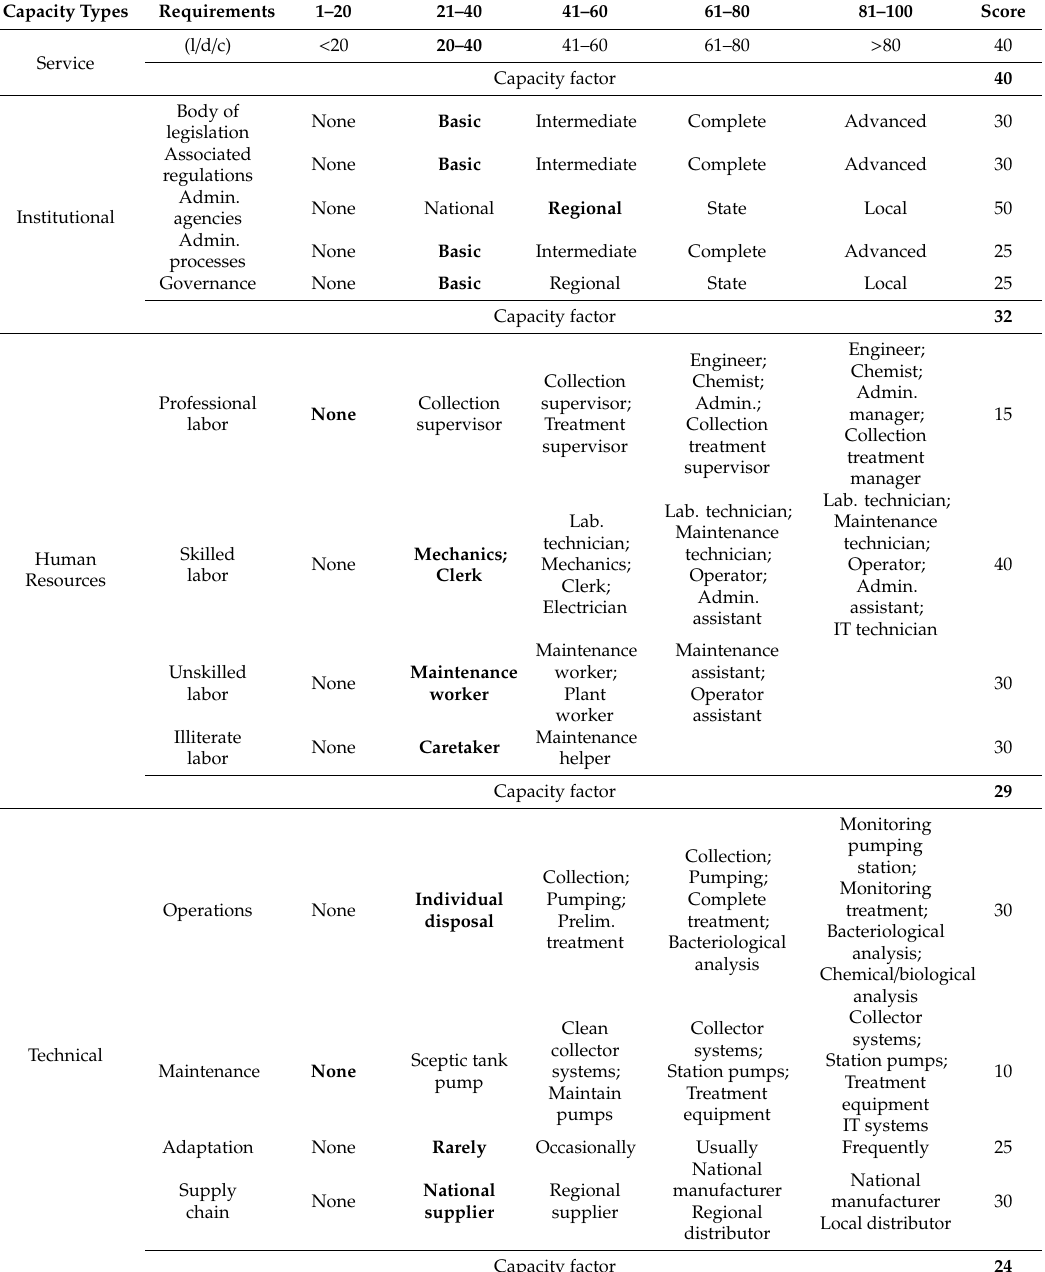
Table 1. Example of wastewater and sewage treatment capacity assessment for a small village in Morocco (from [15,28]). Bold letters apply to the case study being